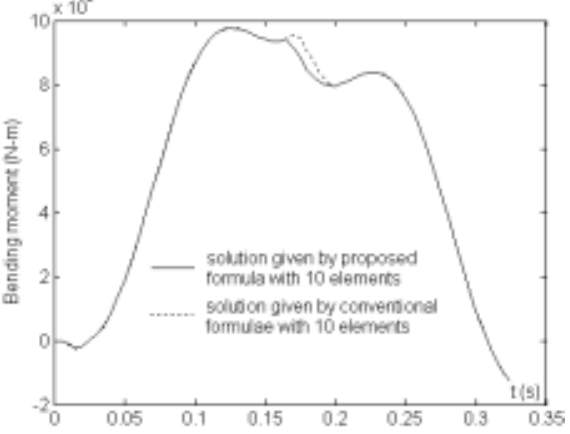
Fig. 12. Time histories for bending moment at the midpoint cross-section of beam with the solutions given by the proposed formula and by the conventional formula with 10 elements.